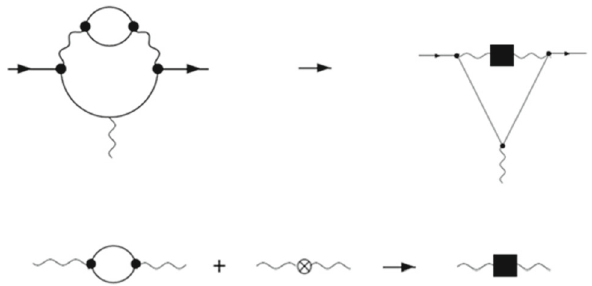
Fig. 2 The schematic diagram for the calculation of the two loop tri- angle diagram of c1 type constraints, we use two mass scales M and M SH for the SUSY particles’ masses. M SH represents heavy SUSY parti- cles mass scale, and squarks masses belong to M SH . M is the light SUSY particle mass scale, the masses of the SUSY par- ticles except squarks are supposed as M . M SH is much larger than M . To simplify the calculation and get the factor easily, we adopt another supposition: considering m Z (cid:4) m W [27],